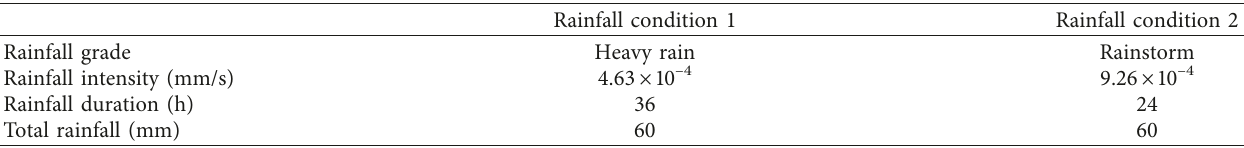
Table 2: Rainfall conditions.